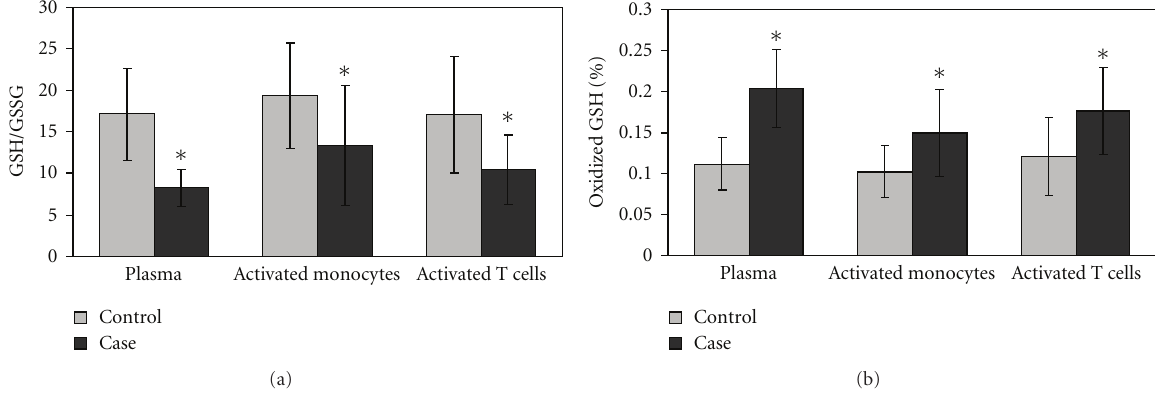
Figure 1: Intracellular and extracellular glutathione redox imbalance in autism. (a) presents the GSH/GSSG in plasma, isolated activated monocytes, and CD4 T cells from case and control children; (b) presents the % oxidized glutathione equivalents. Both extracellular and intracellular glutathione redox status are consistently significantly decreased among the case children ( ∗ P < 0 .